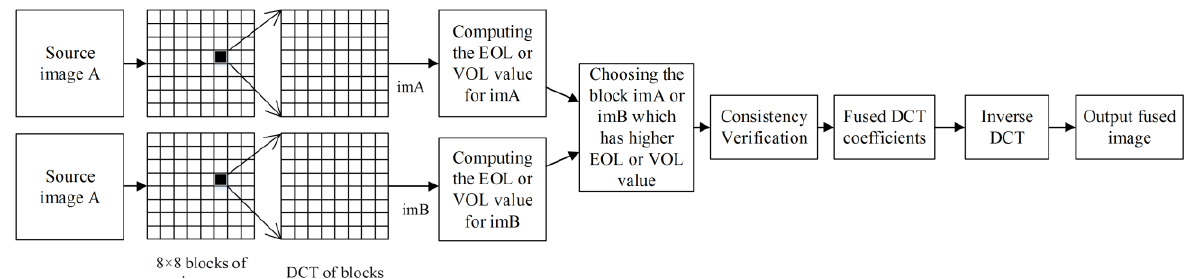
Figure 2. General structure of second approach in proposed